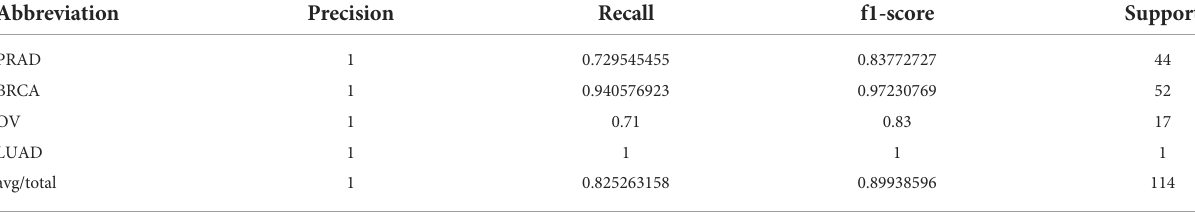
TABLE 3 The model test results (precision, recall, and f1-score) of 4 cancers on the GEO dataset. Abbreviation